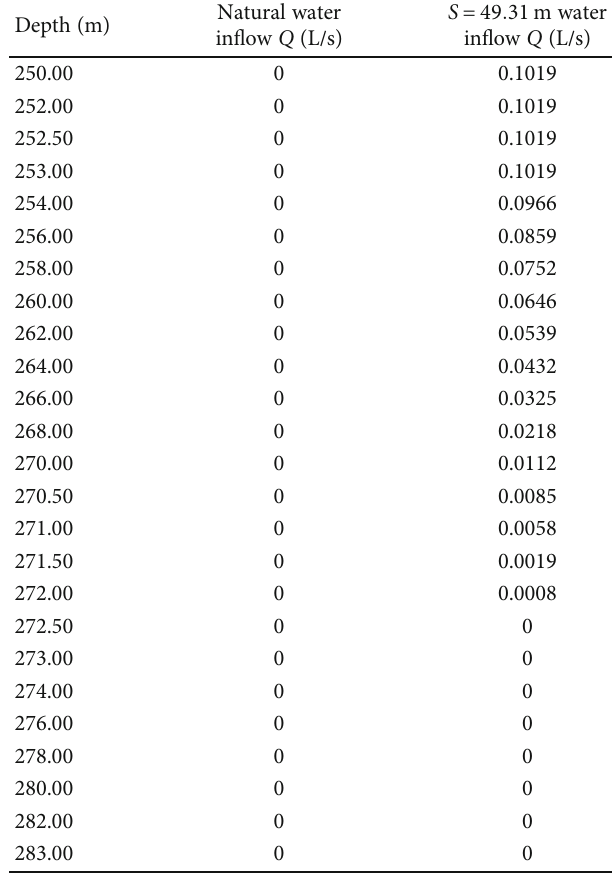
Table 3: Water in fl ow of each measuring